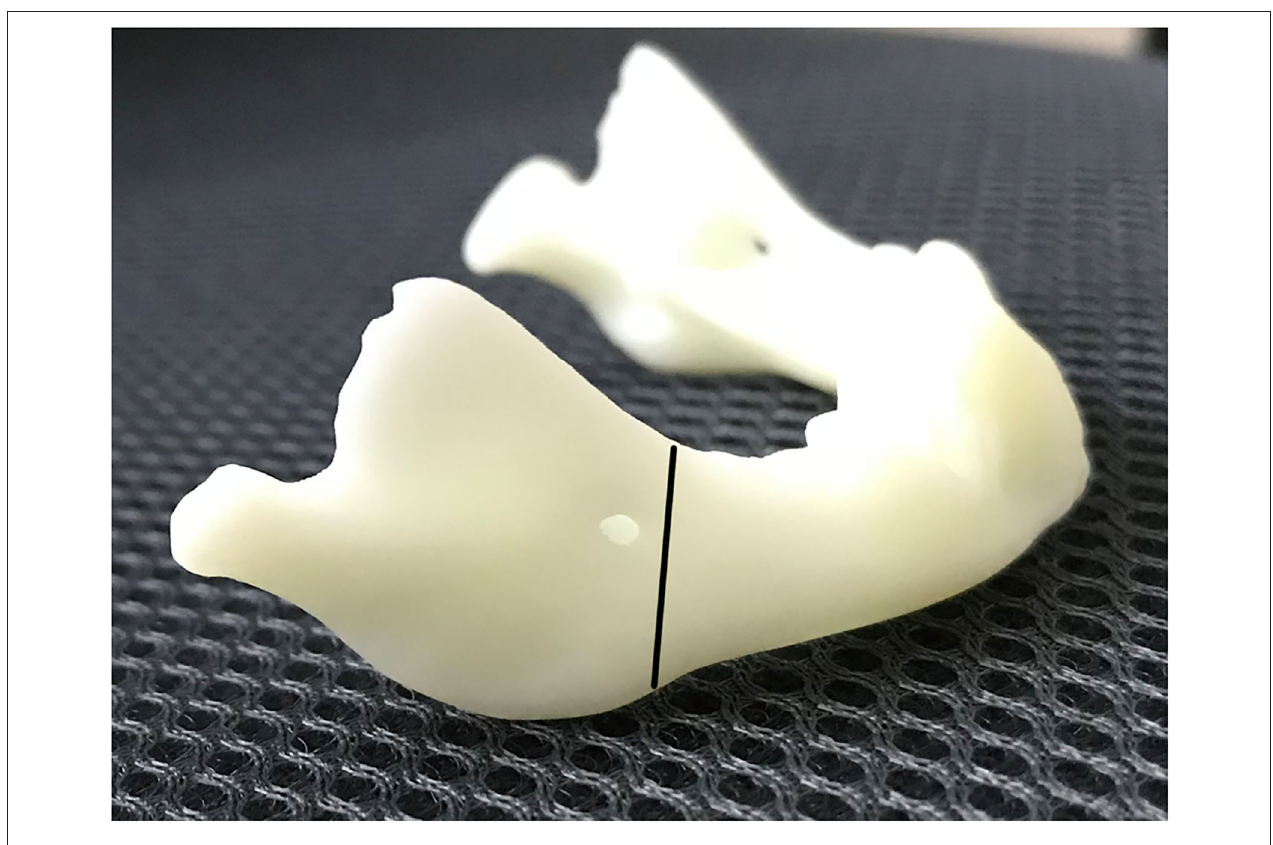
FIGURE 1 | The oblique osteotomy is planned.